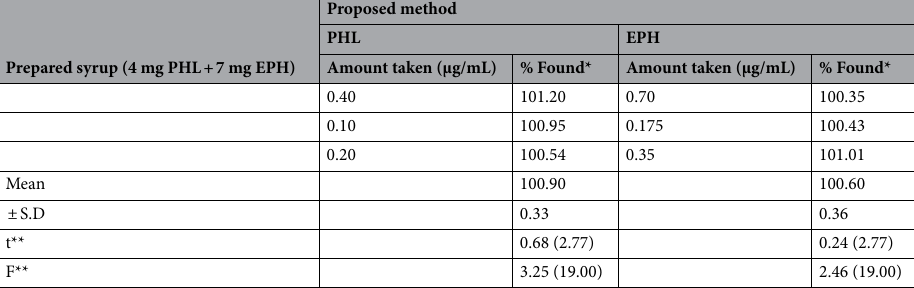
Table 5. Determination of pholcodine and ephedrine in their prepared syrup by the synchronous spectrofluorimetric method (Method II). *Each result is average of 3 separate determinations. **Values between parentheses are the tabulated values of t-test and F-test at p = 0.05 50 .